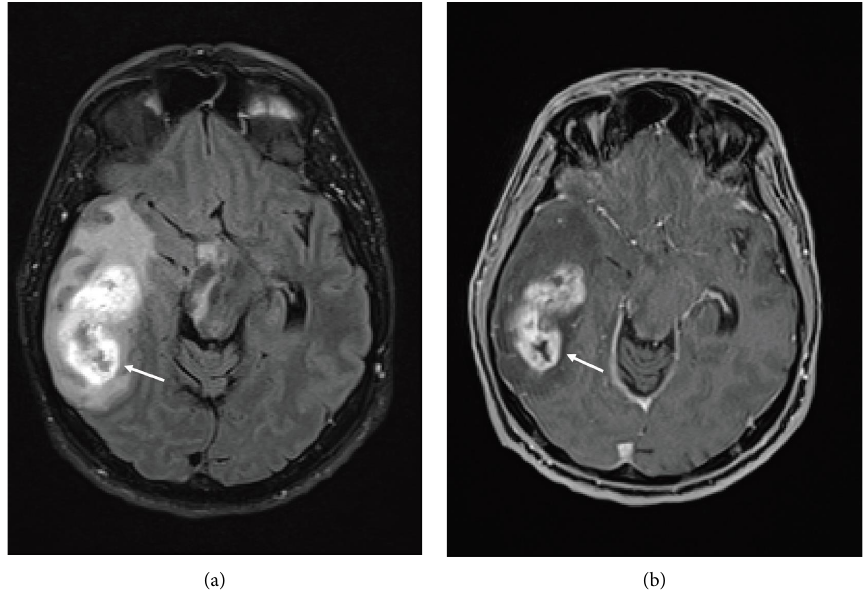
Figure 2: Axial, contrast-enhanced MR images at the middle cranial fossa level. (a) FLAIR and (b) T1-weighted images demonstrate an irregular enhancing mass lesion with central areas of necrosis within the right temporal